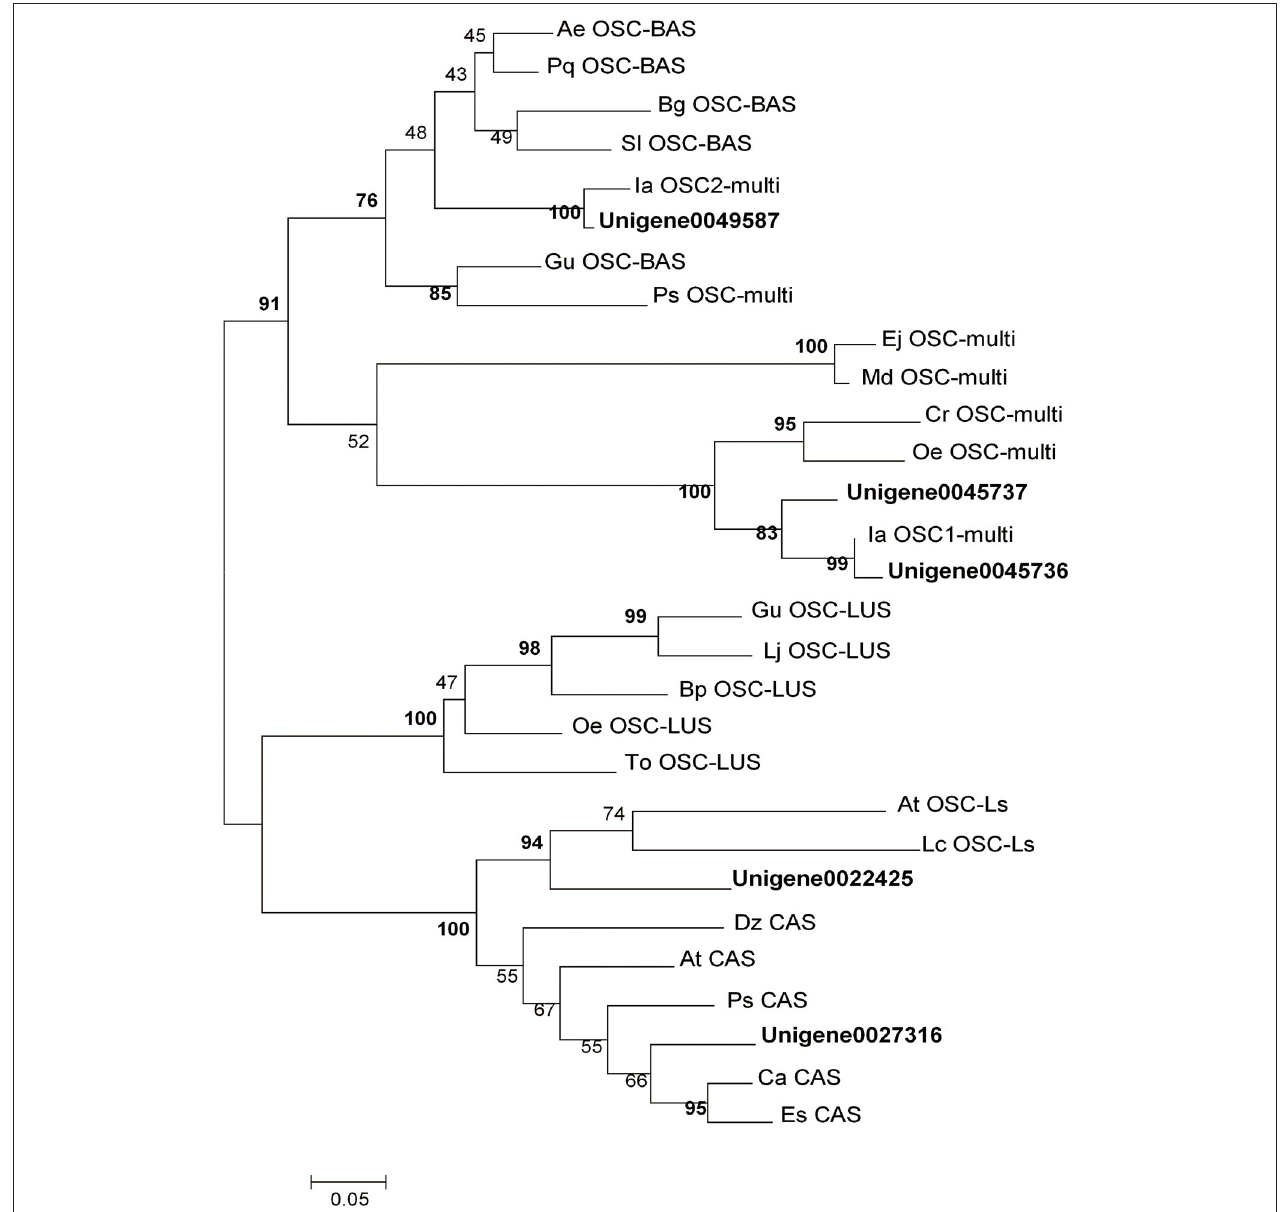
FIGURE 2 | Phylogenetic analysis of OSCs. The statistical methods of this unrooted tree was maximum likehood method, which was tested by bootstrap method and the number of bootstrap replications was 1,000. The bold indicate the OSCs were selected from I. pubescens transcriptome and the others were randomly selected from GenBank. Ae, Aralia elata; At, Arabidopsis thaliana ; Bp, Betula platyphylla ; Ca, Cicer arietinum ; Cr, Catharanthus roseus ; Dz, Dioscorea zingiberensis ; Ej, Eriobotrya japonica ; Es, Eleutherococcus senticosus ; Gu, Glycyrrhiza uralensis ; Ia, Ilex asprella ; Lc, Luffa cylindrica ; Lj, Lotus japonicus ; Md, Malus domestica ; Oe, Olea europaea ; Pq, Panax quinquefolius ; Ps, Pisum sativum ; Sl, Solanum lycopersicum ; To, Taraxacum officinale . BAS, β -amyrin Synthase; CAS, cycloartenol synthase; LUS, lupeol synthase; LS, lanosterol synthase; Multi, multifunctional OSC